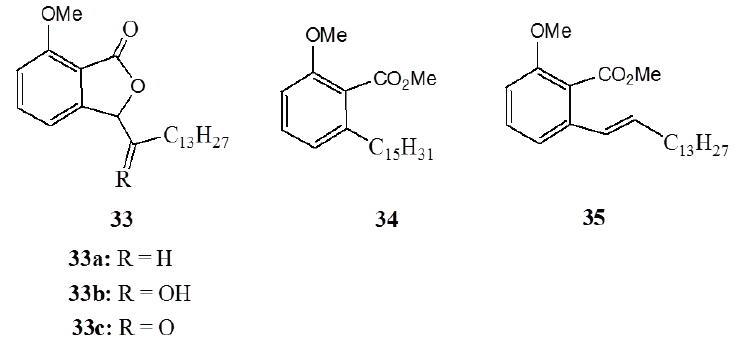
Figure 13. The cytotoxic compounds 33 – 35 .